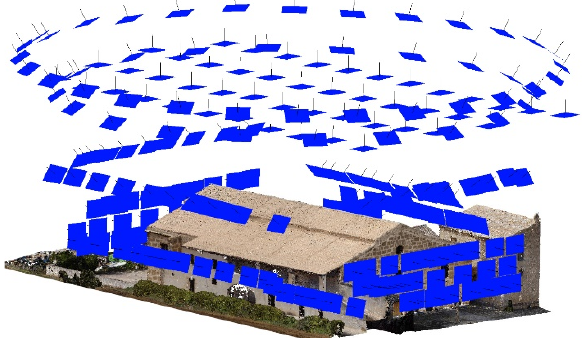
Figure 9 . Scheme of UAV